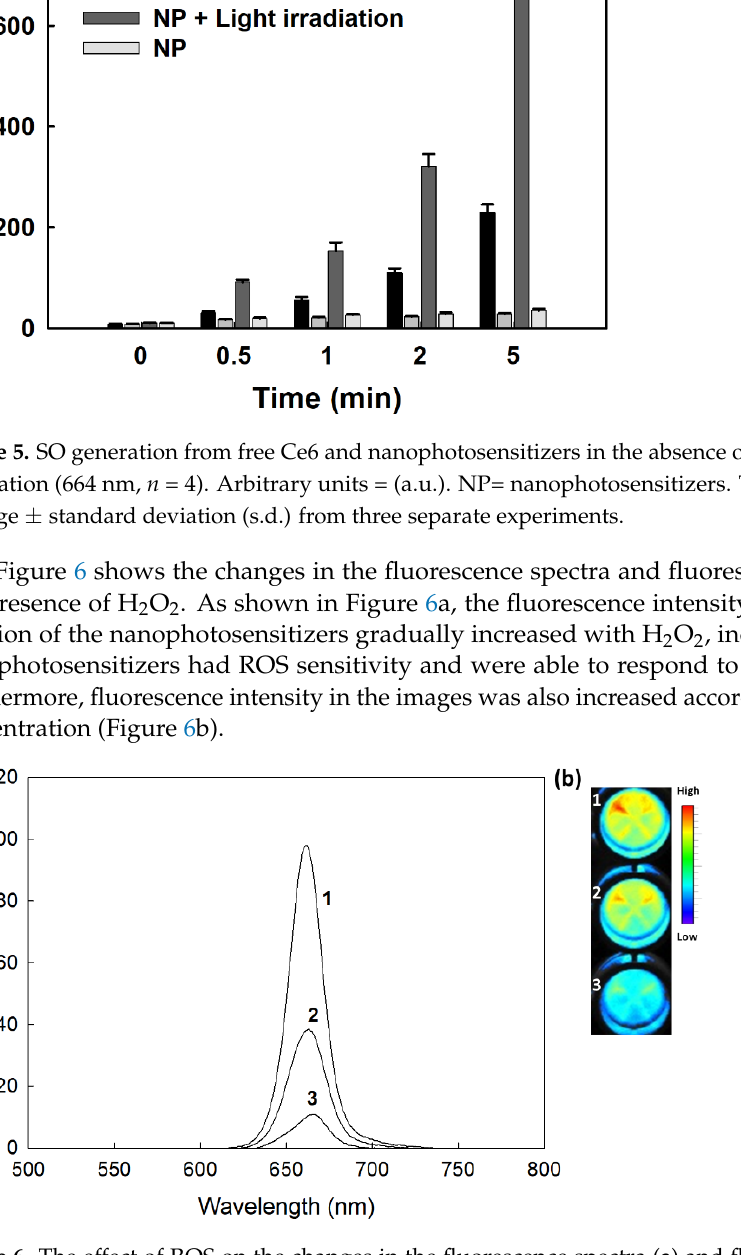
Figure 4. The effect of ROS on the changes in the particle size distribution ( a – c ) and morphology ( d – f ) of nanophotosensitizers. ( a , d ) H 2 O 2 , 0 mM; ( b , e ) H 2 O 2 , 0.5 mM; ( c , f ) H 2 O 2 , 2.0 mM. Nanophotosensitizers in PBS (pH 7.4, 0.01 M), incubated at 37 °C for 3 h in the absence or presence of H 2 O 2 .